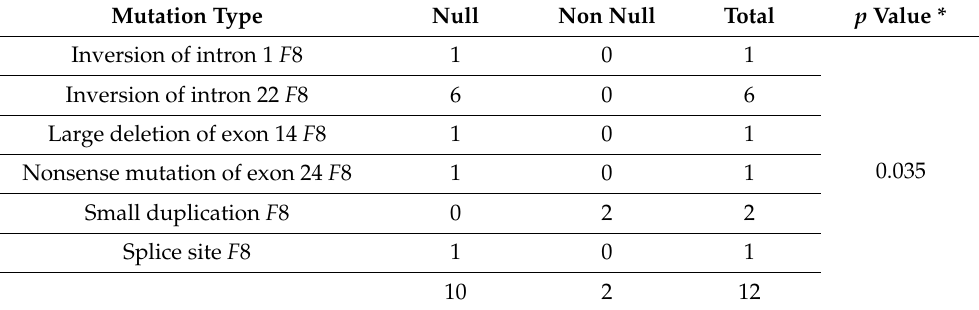
Table 4. Association between type of mutation and null